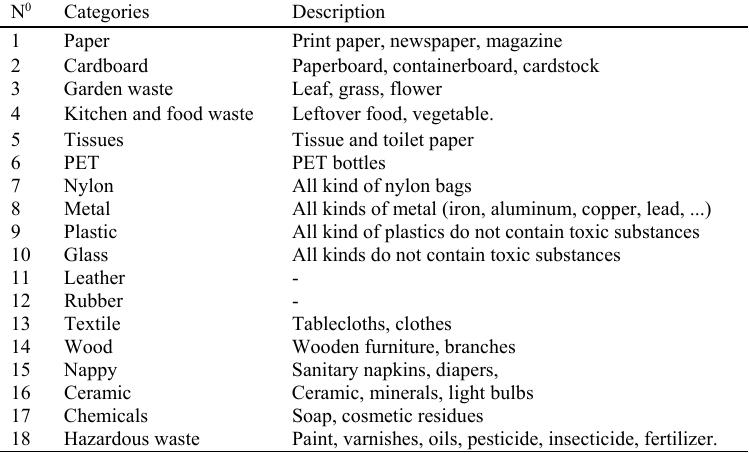
Table 2: Categories of waste composition